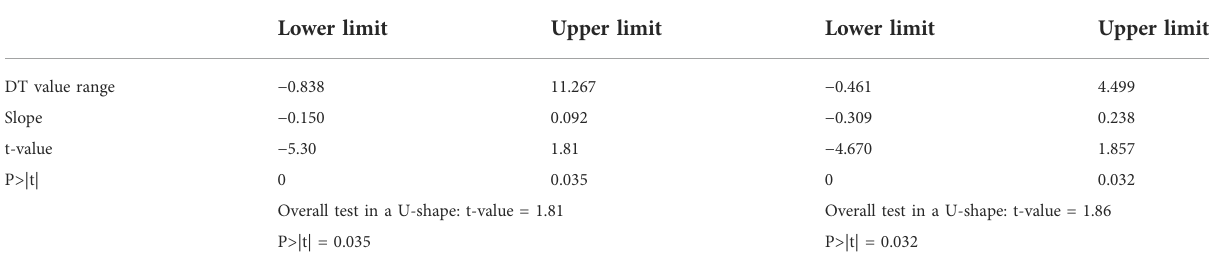
TABLE 10 U-test of mediating effect. Table 9 column (3) U-test Table 9 column (6)